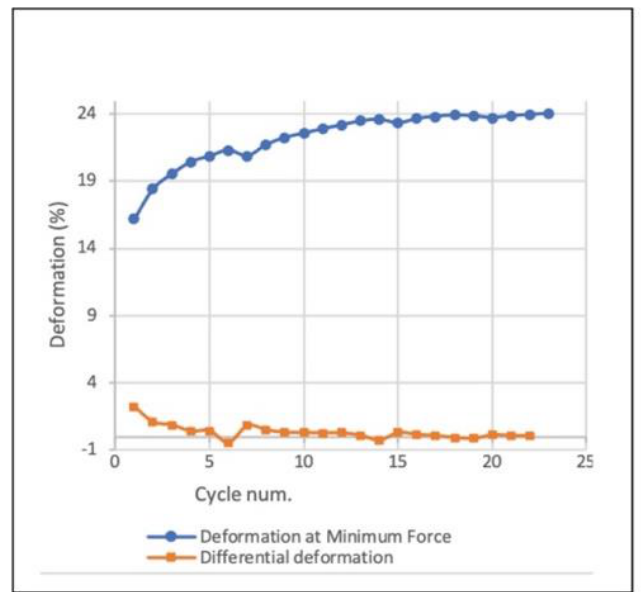
Figure 7. Accumulated irreversible deformation across loading cycles: plotted deformation at minimal applied force (blue) and differential deformation (orange).